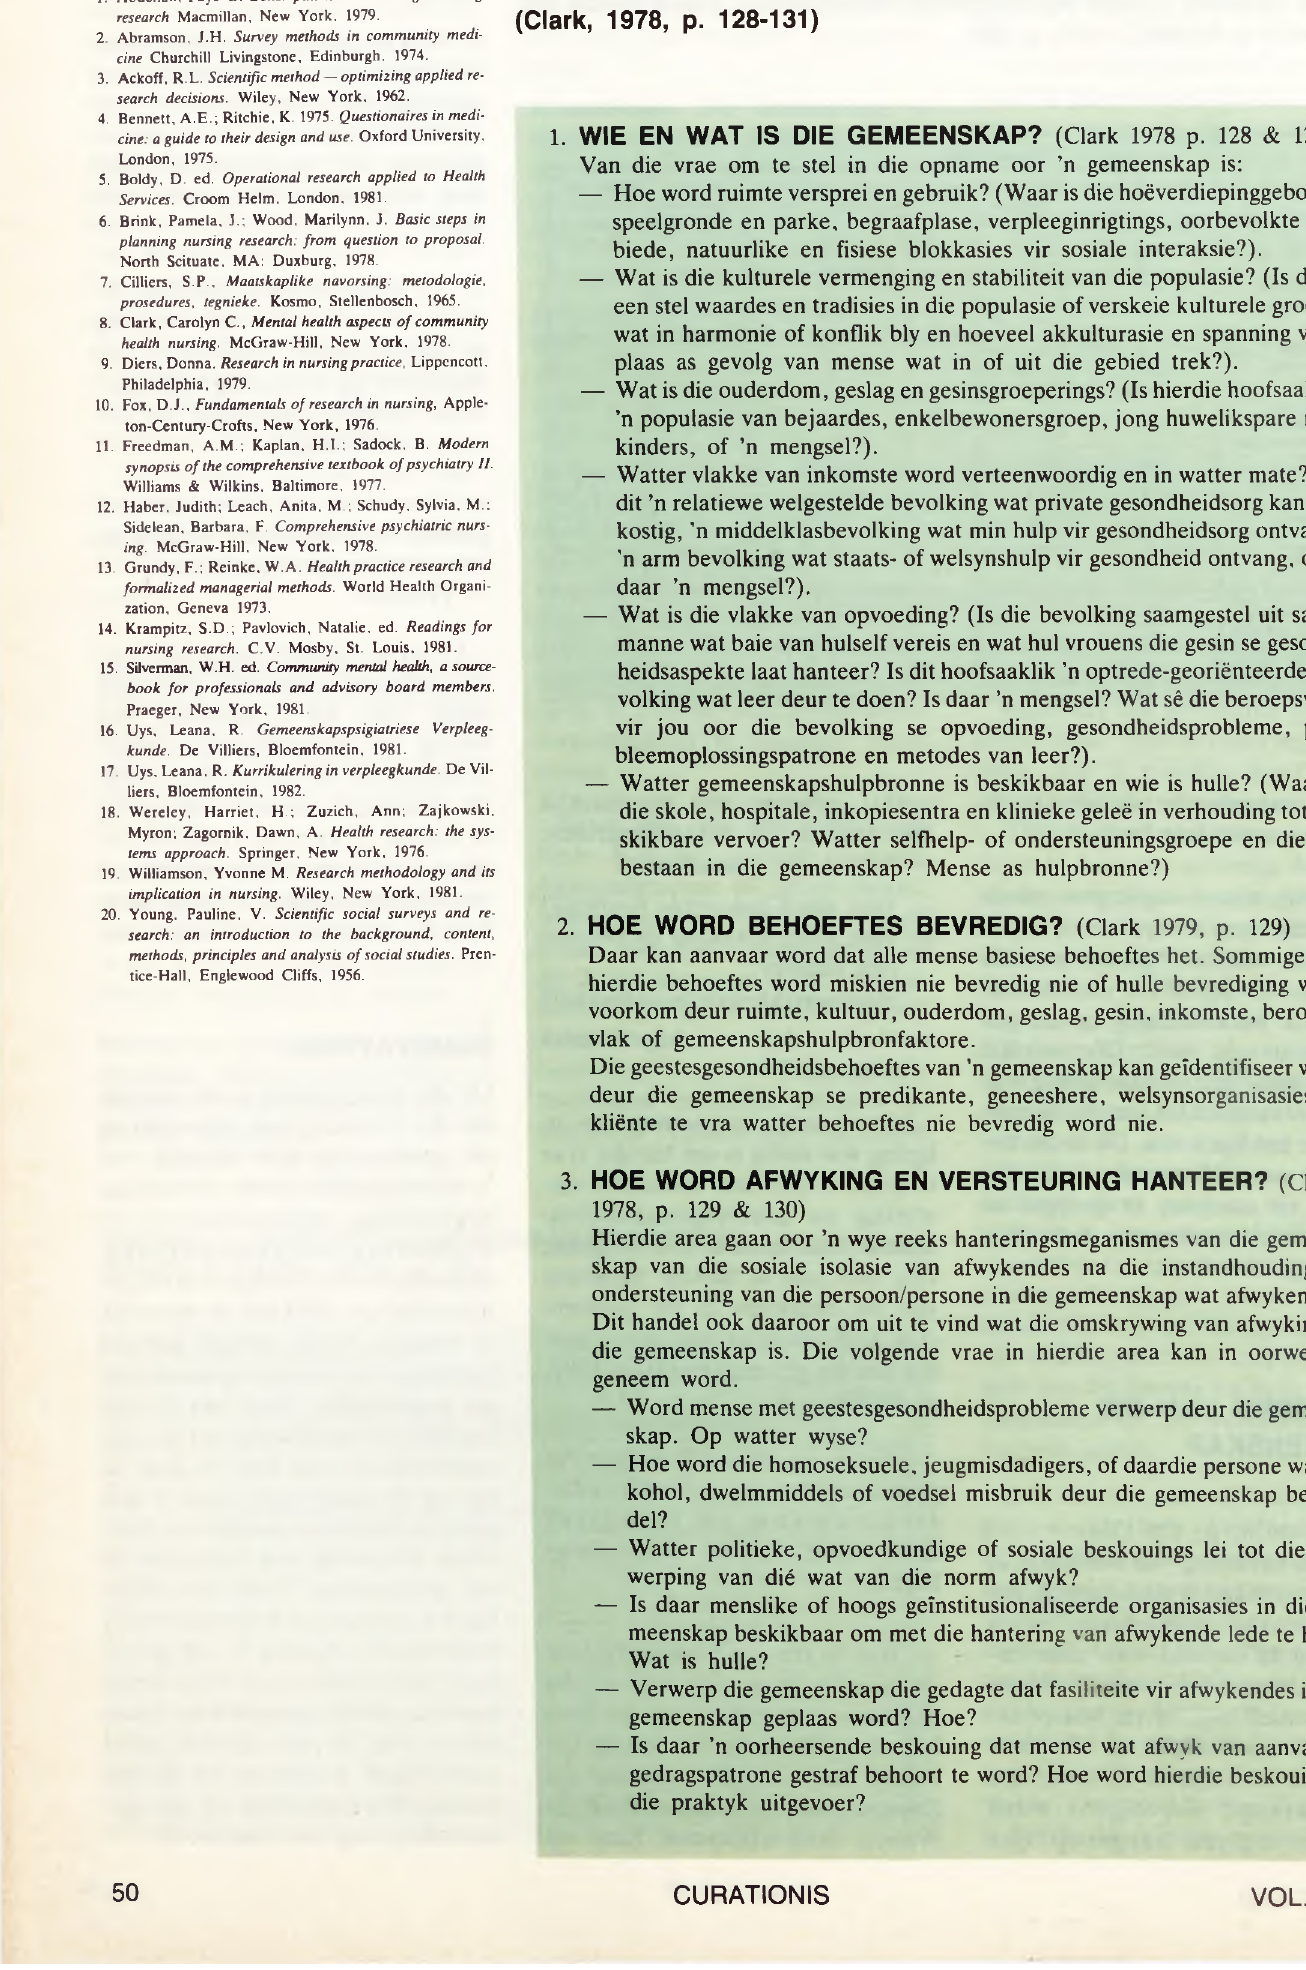
Tabel 2: RIGLYNE VIR DIE BERAMING VAN DIE GEMEENSKAP